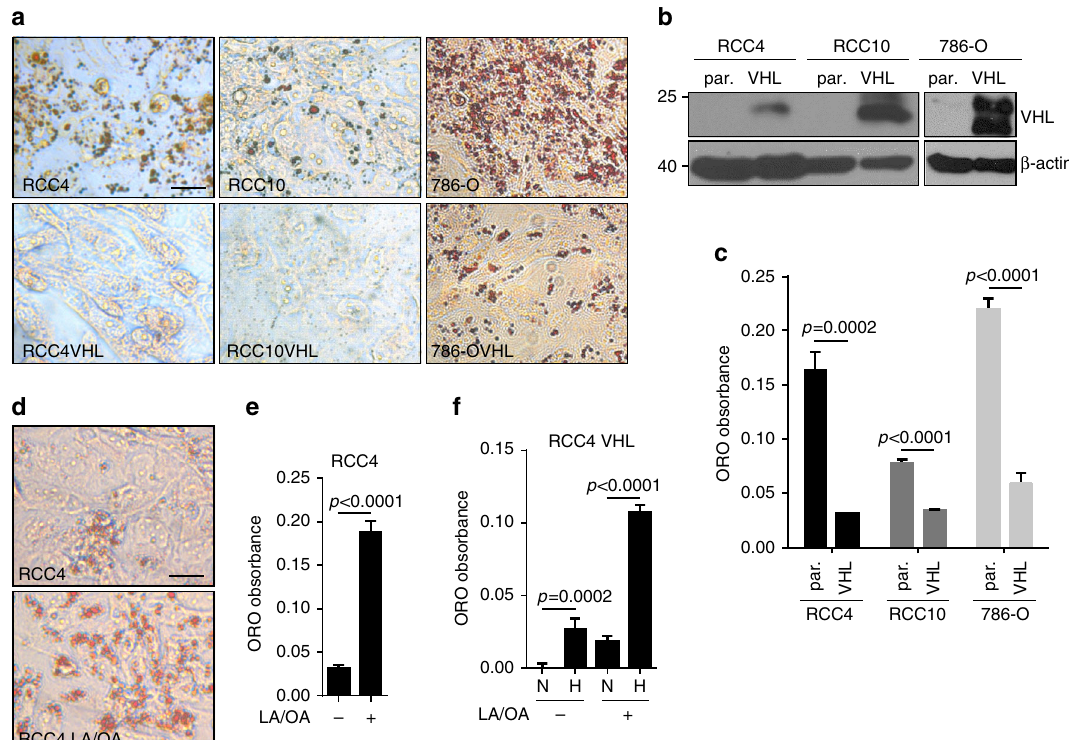
Fig. 1 Lipid accumulation in ccRCC cells is VHL dependent. a Photomicrographs of RCC4, RCC10, and 786-O renal cell lines with or without VHL stained with Oil Red O 6 days after reaching con fl uence. b Western blot demonstrating VHL expression in reconstituted lines. β -actin used as loading control. c Quanti fi cation of Oil Red O extracted from cells shown in a . d Oil Red O staining of RCC4 cells 2 days after treatment with linoleic/oleic acid (LA/OA). e Quanti fi cation of Oil Red O staining of cells in d . f Quanti fi cation of Oil Red O staining of RCC4 VHL cells treated with LA/OA cultured in either normoxia (N) or 1% oxygen (H). Statistical tests for all panels were two-tailed Student ’ s t tests. Scale bar = 10 μ m. Error bars represent standard